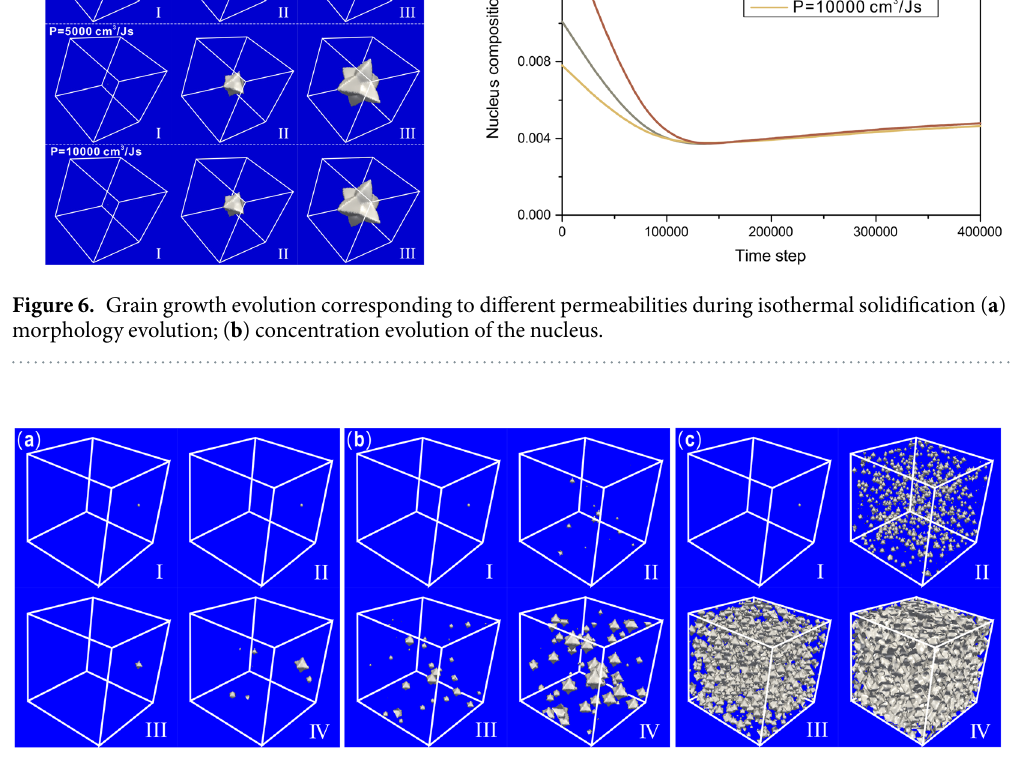
Figure 7. Three-dimensional phase-field simulated nucleation process of Al-2.89 at. % Si alloy during isothermal solidification with different interfacial permeabilities: ( a ) P = 1000 cm 3 /Js; ( b ) P = 5000 cm 3 /Js; ( c ) P = 10000 cm 3 /Js.